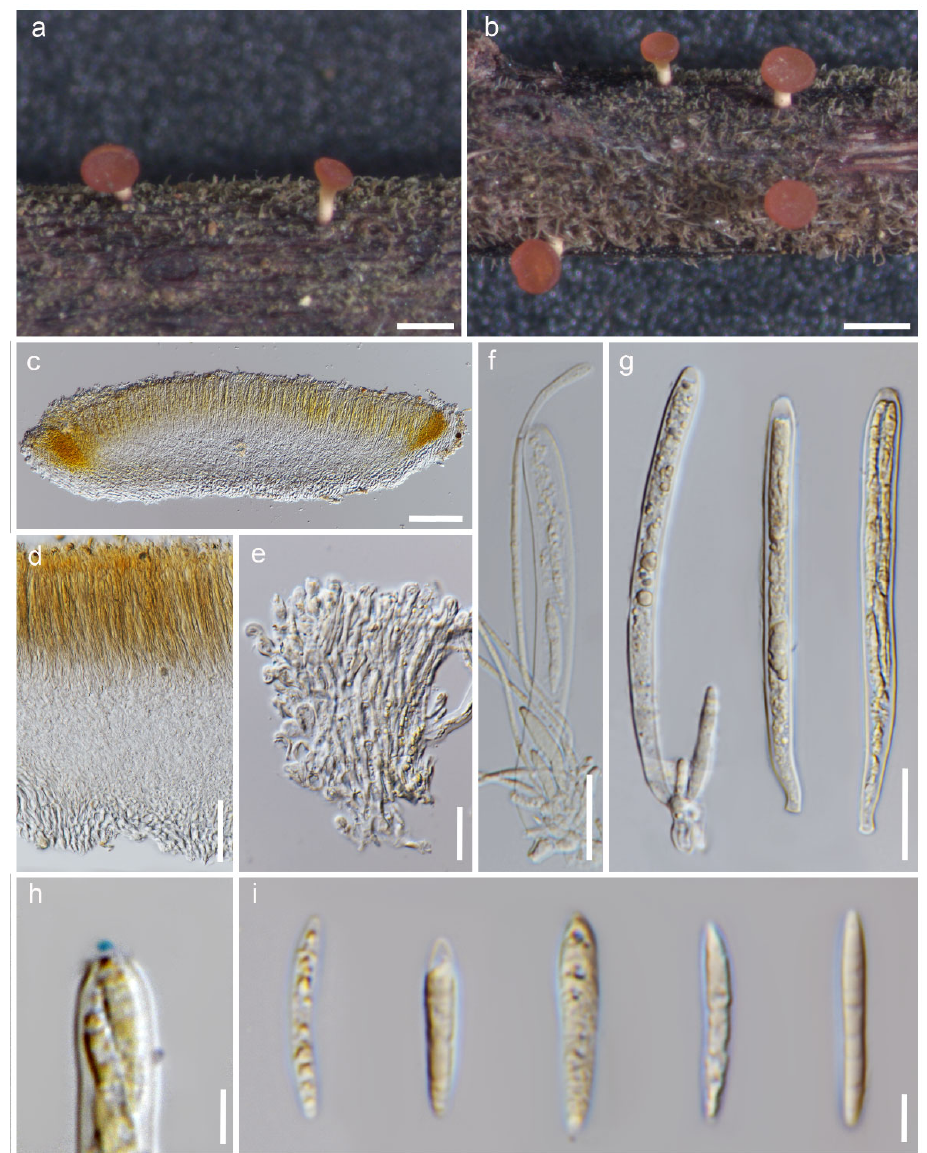
Figure 5. Dicephalospora chiangraiensis (MFLU 21 ‐ 0018, holotype). ( a , b ) D . chiangraiensis on the stem; ( c ) cross section of the apothecium; ( d ) close up of the excipulum; ( e ) margin of the apothecium; ( f ) filiform paraphyses; ( g ) cylindrical asci; ( h ) apical part of asci in Melzer’s reagent; ( i ) fusiform ascospores. Scale bars: ( a , b ) = 500 μ m; ( c ) = 100 μ m; ( d ) = 50 μ m; ( e – g ) = 20 μ m; ( h , i ) = 5 μ m.